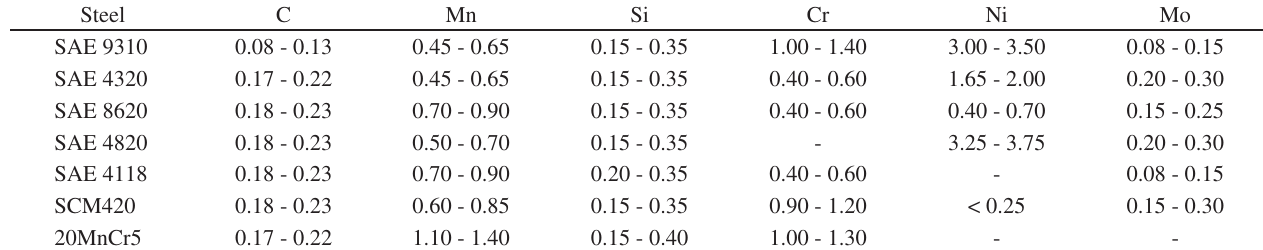
Table 1. Nominal compositions of automotive carburizing steels; S and P less than 0.025 (wt. pct). Steel